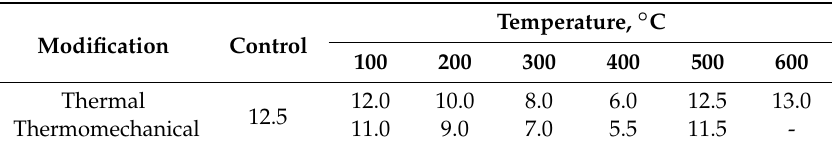
Table 5. Wear intensity of carbon diber-reinforced plastic (CFRP; I · 10 − 7 mm 3 /N · m) at introduction of CF after thermal and thermomechanical